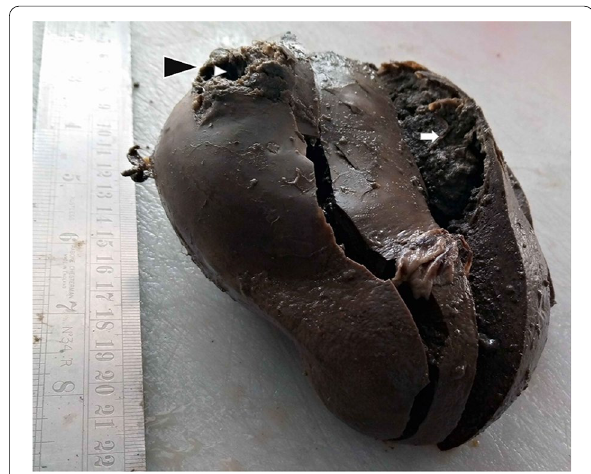
Fig. 3 Gross picture of the spleen with a cystic cavity containing tumor (arrow) and necrotic material. a focal area of rupture by the tumor is seen